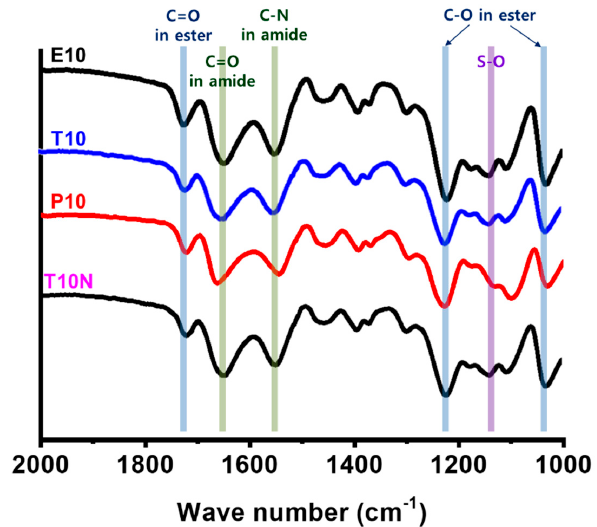
Figure 4. FTIR spectra of poly(2-acrylamido-2-methyl-1-propanesulfonic acid) (PAMPS) membranes.